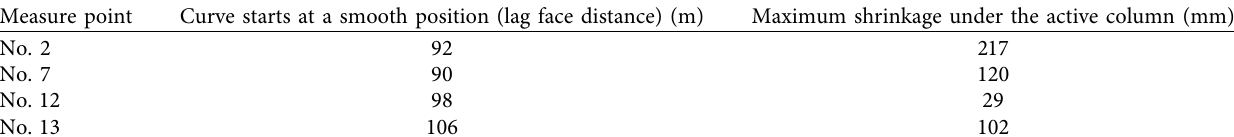
Table 6: Key positions and maximum value of the accumulated lower shrinkage of active columns on the change curve.